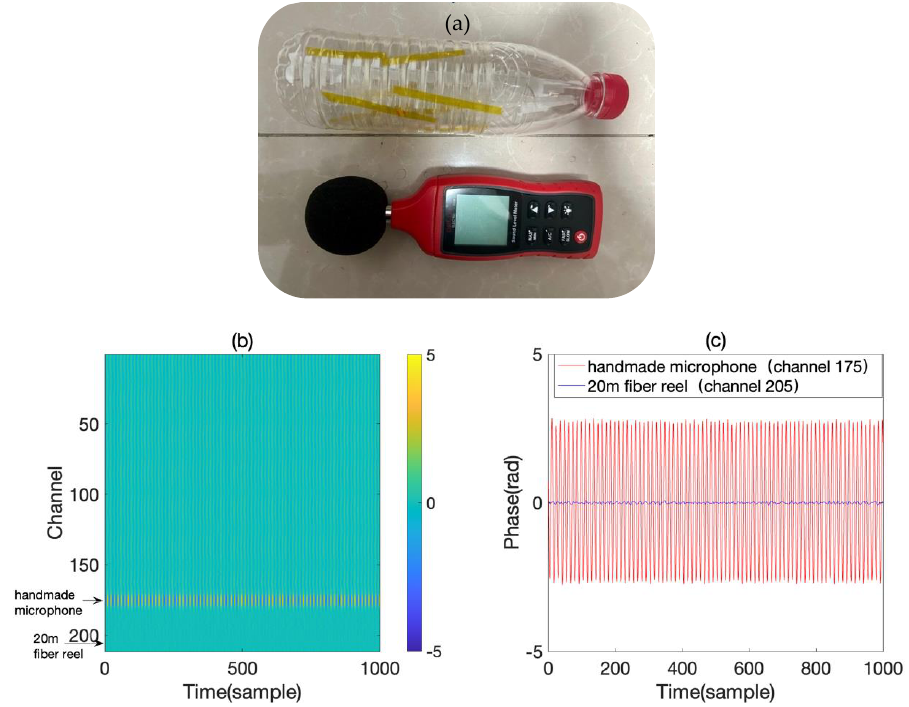
Figure 4. ( a ) Handmade microphone (up) and sound level meter SLM (down). ( b ) Phase